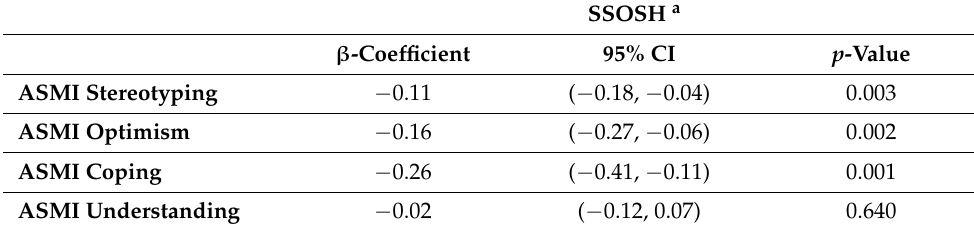
Table 5. Associations of attitudes towards mental illness and self-stigma of help-seeking, multivariate analysis. SSOSH a β -Coefficient 95% CI p -Value −